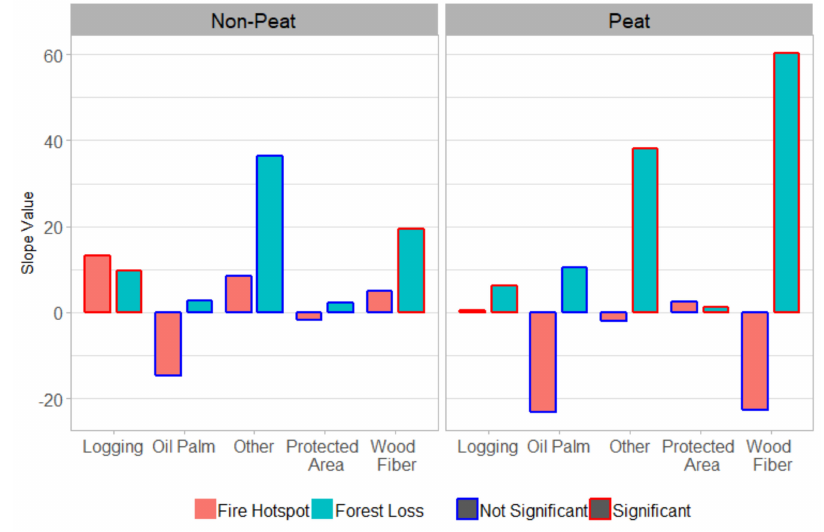
Figure 8. Annual increment in the number of fire hotspots (year − 1 ) and the rate of forest loss (km 2 year − 1 ) in non-peat and peat